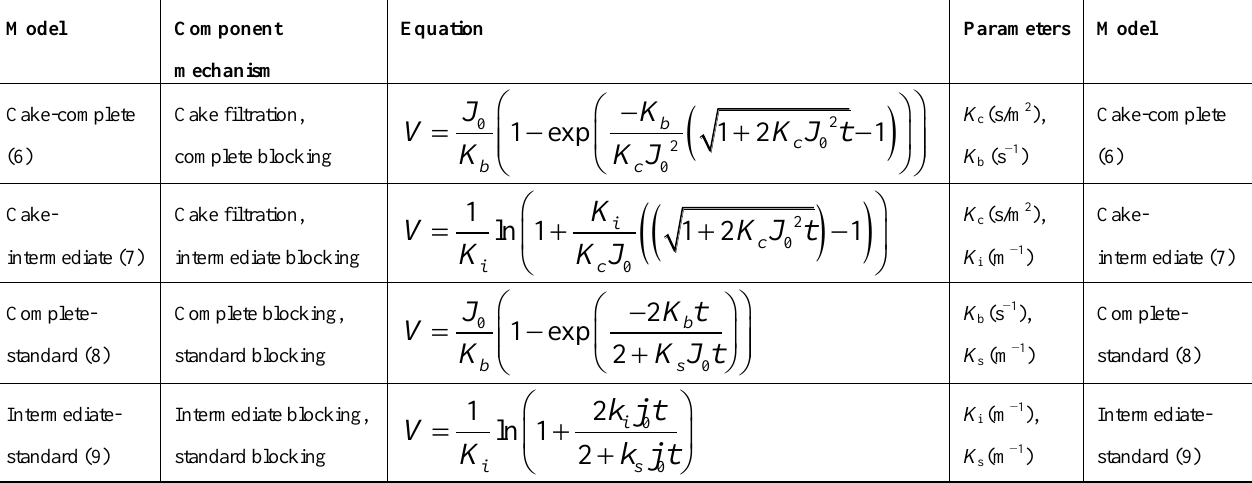
Table 2. Summary of the combined models used for constant pressure dead end